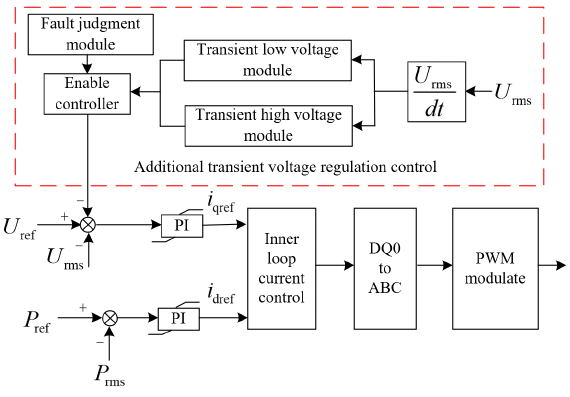
Fig. 5. Transient voltage regulation coordinated control strategy diagram.